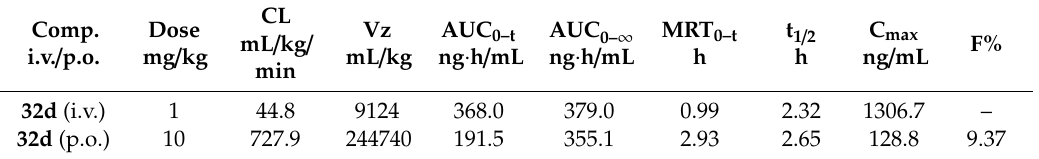
Table 8. PK Parameters of 32d in SD Rats ( n = 3)